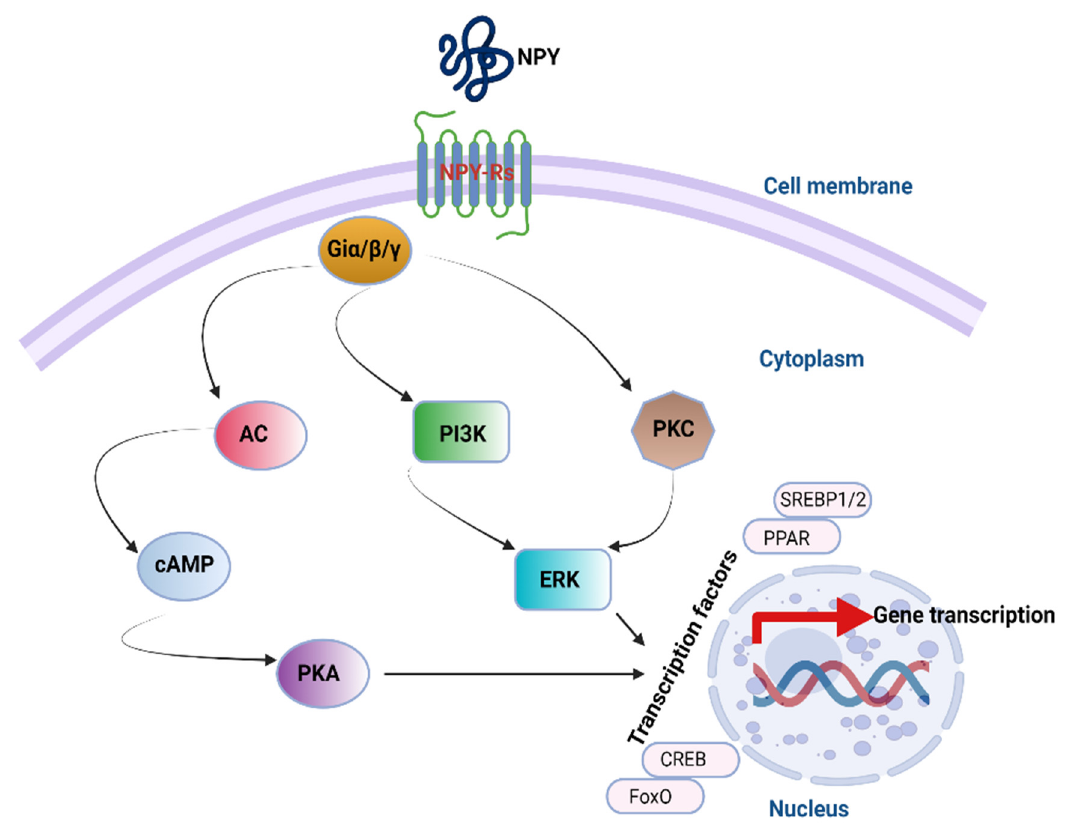
Figure 2. NPY downstream signaling pathways. The representation shows the potential main path- ways through which NPY signals. AC, adenylate cyclase; cAMP, cyclic adenosine monophosphate; CREB, cAMP response element binding protein; ERK, extracellular signal-regulated kinase; FoxO, Forkhead Box O; PI3K, phosphatidylinositol-3-kinase; PKA, protein kinase A; PKC, protein kinase C; PPAR, peroxisome proliferator-activated receptor; SREBP, sterol regulatory element-binding protein. The figure was made using Biorender.com.